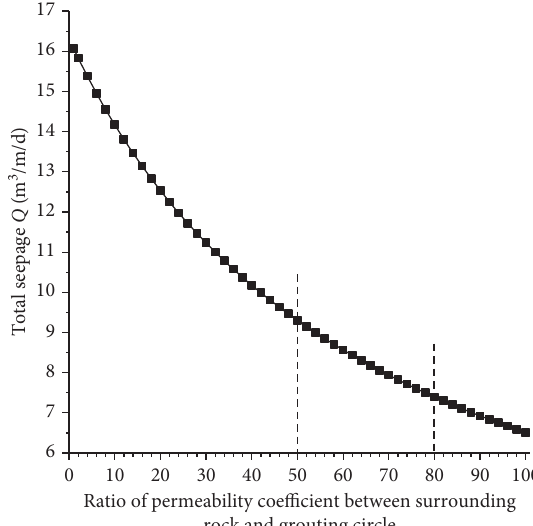
Figure 6: Relationship between the permeability coefficient and the water seepage of the grouting circle.